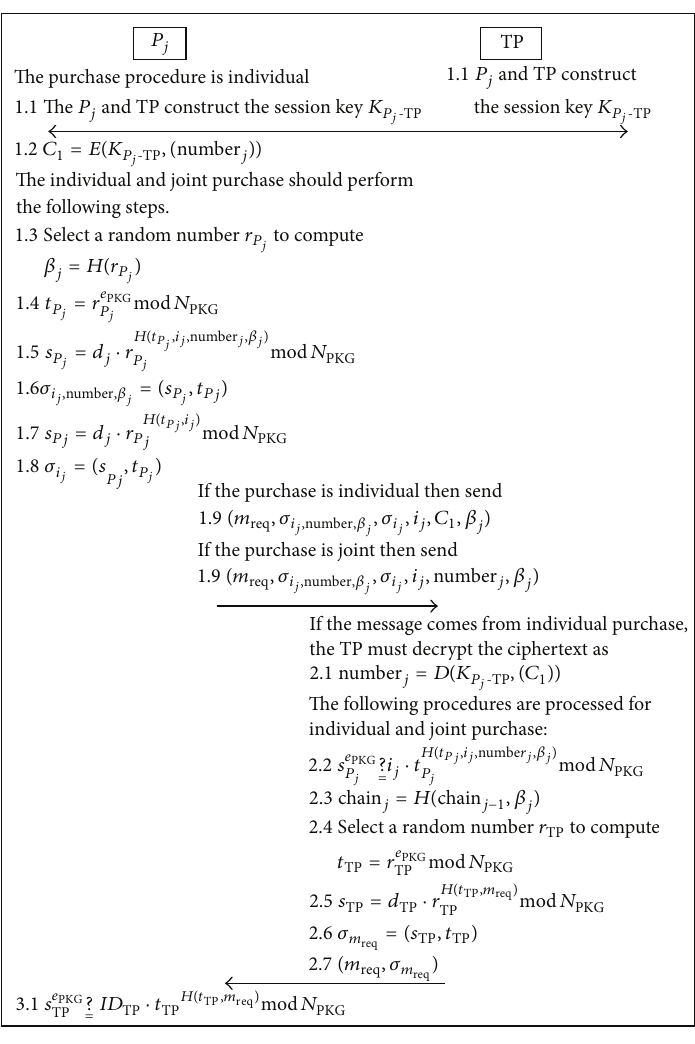
Figure 2: Overview of the players bet for lottery number